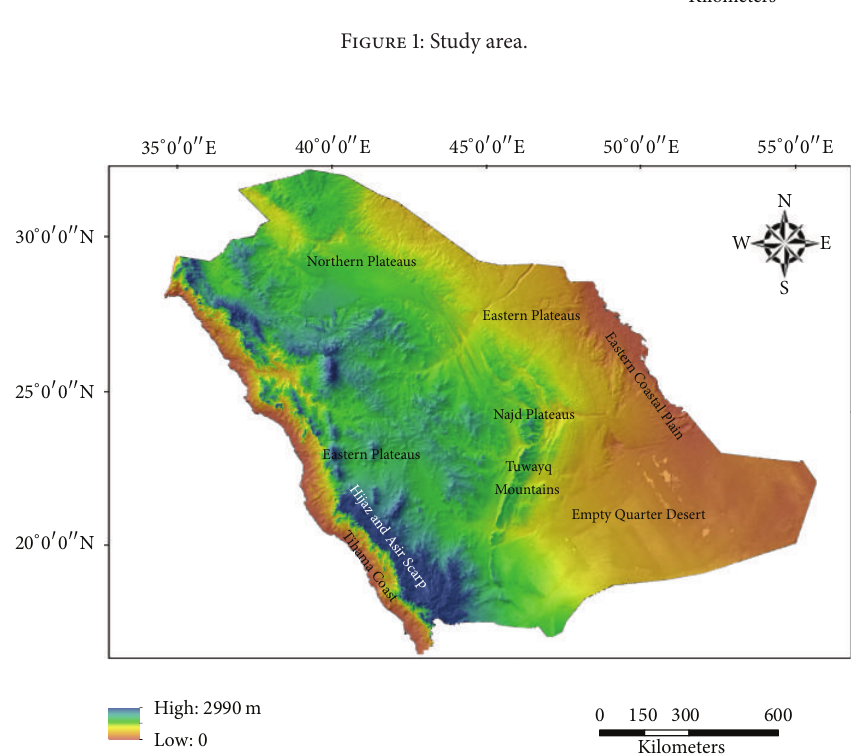
Figure 1: Study area.